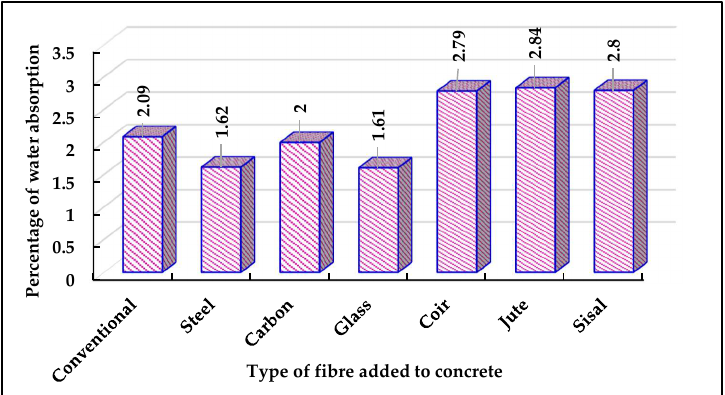
Figure 9. Graphical illustration of water absorption of FRC.